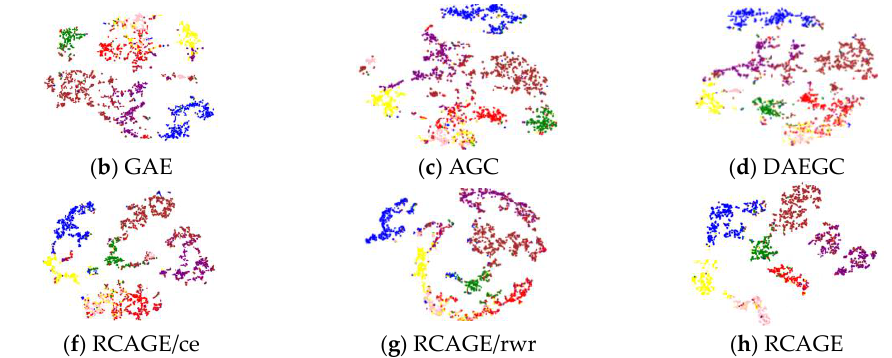
Figure 5. Visualization of node embeddings learned by different models on Cora.